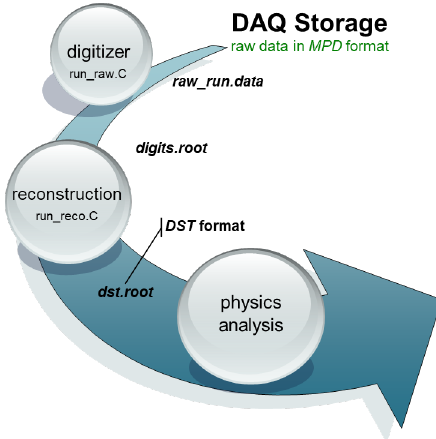
Fig. 2. Experimental data processing chain in the BmnRoot